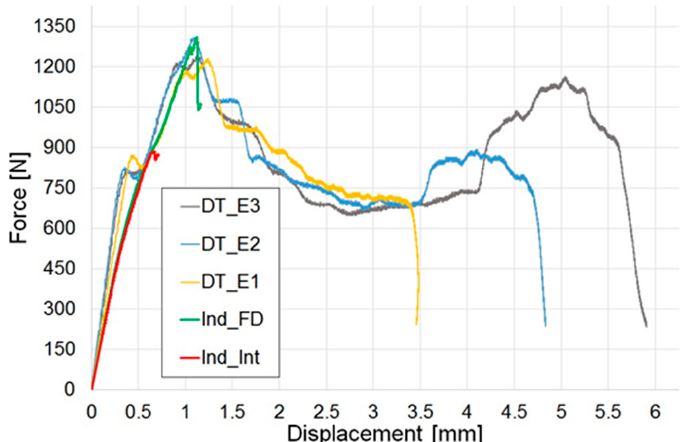
3.2 J (DT_E2) and 4.2 J (DT_E3), respectively.